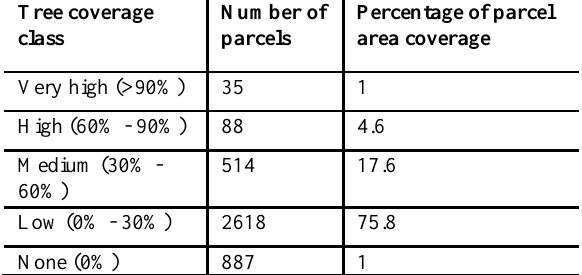
Table 1. Parcels level statistics in different tree coverage